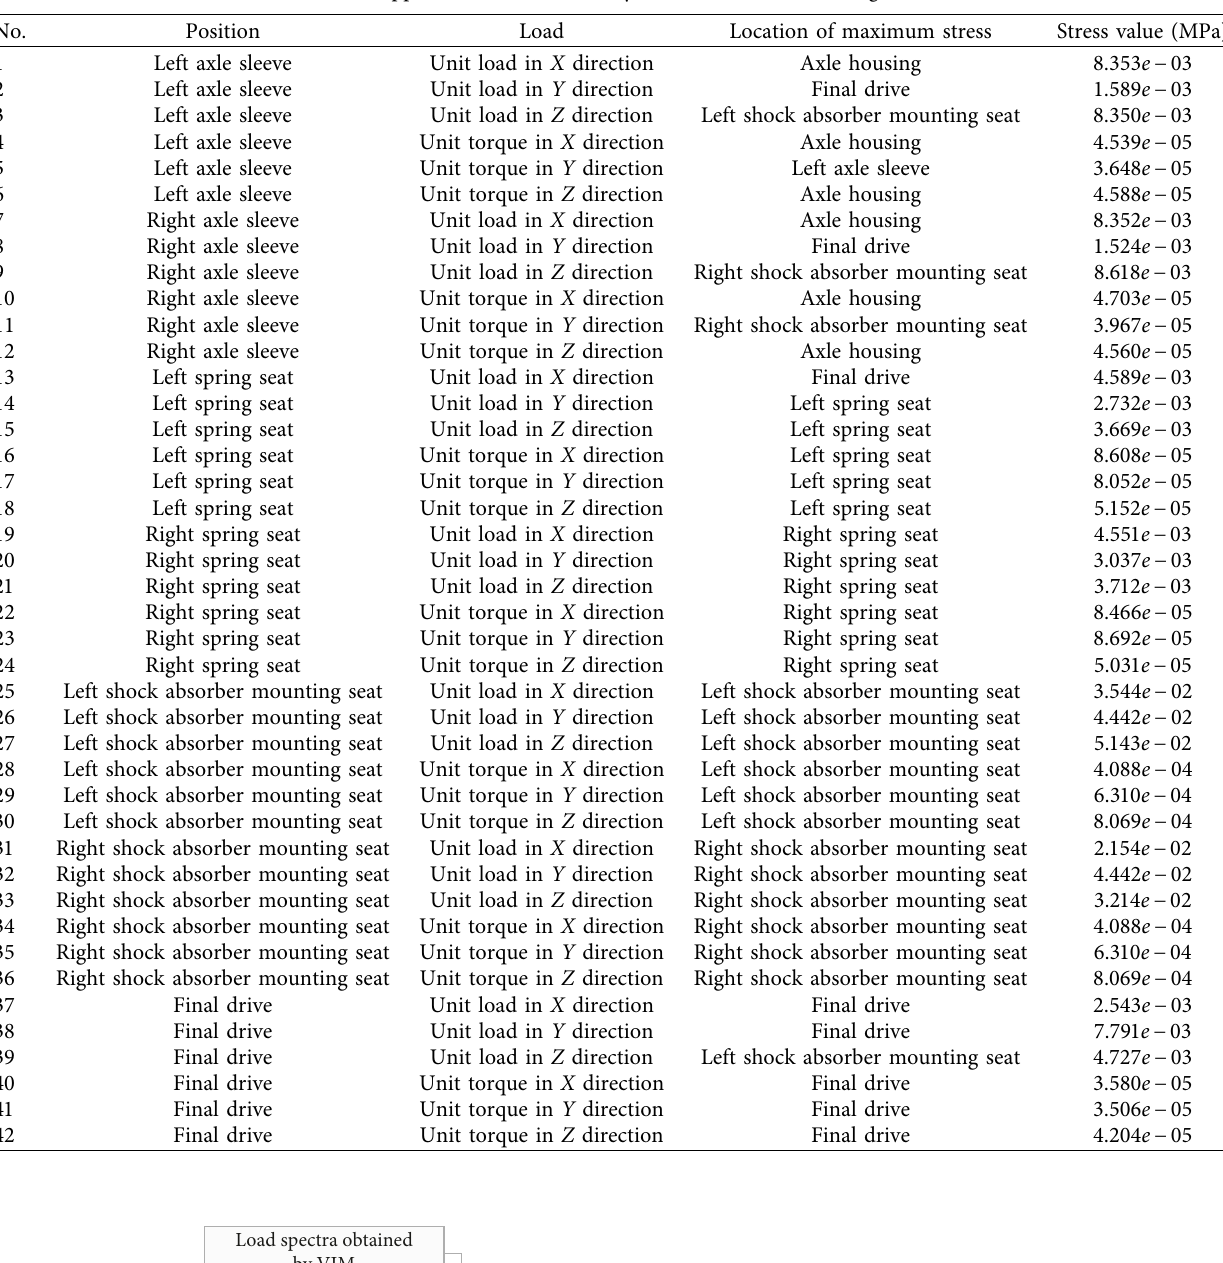
Table 3: Load application and static analysis results of each working condition.